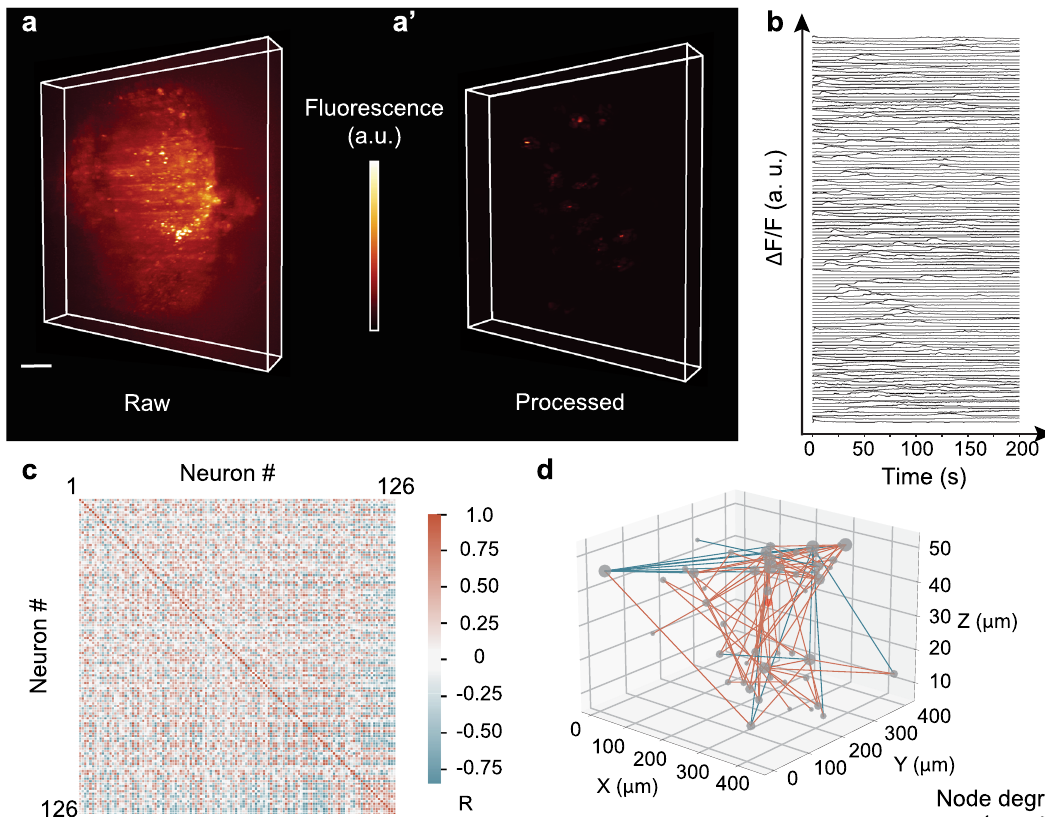
Figure 5. Quantification of neuronal responses in 3D neuron cultures. ( a ) 3D lightsheet image of a single timepoint (R-GECO1.0 calcium sensor, raw data). ( a ’) Same image after the processing pipeline. Only active neurons remain in the observation volume. ( b ) Individually normalized calcium traces. The vertical offset serves display purposes. ( c ) A Spearman rank correlation matrix between any pair of active neurons was constructed using the raw fluorescence traces, ordered according to their distance from the centre of mass (COM). R represents the correlation coefficient value between each pair traces. ( d ) 3D functional connectivity map. Edges are coloured corresponding the R-value of the connection. Only strongest connections with |R|> 0.8 are kept. Nodes’ s size is degree-coded. The red dot represents the COM. Color bar scaling (a.u.): 1584–3778 ( a ), 0.44–0.64 ( a ’). Scale bar: 50 µ m ( a